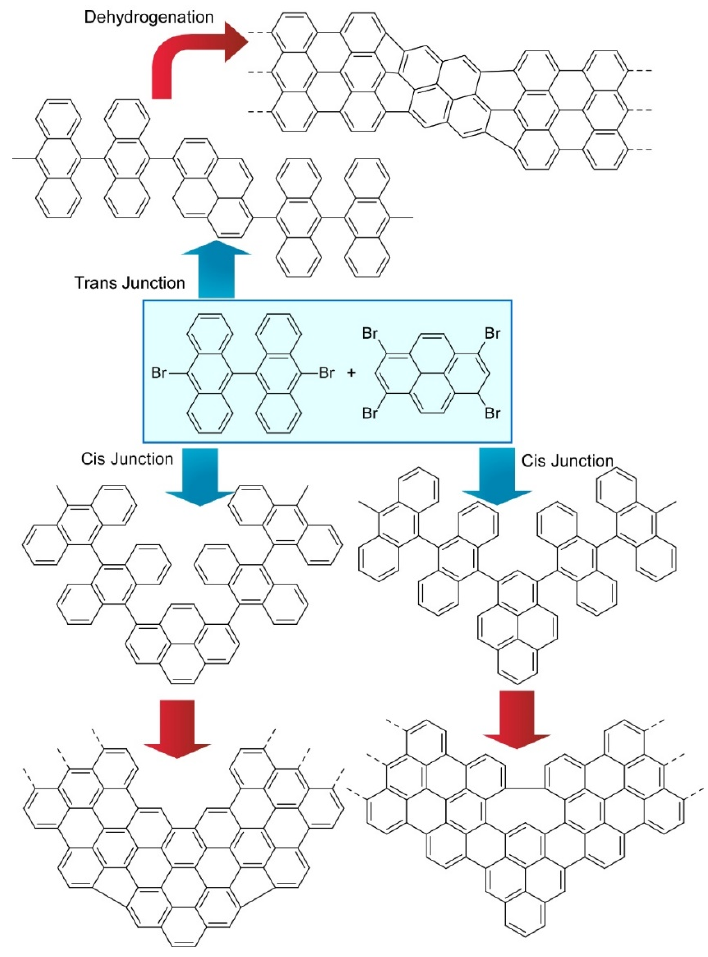
Figure 8. Three different regioisomeric junctions synthesized from 10,10’-dibromo-9,9’-bianthryl and 1,3,6,8-tetrabromopyrene on Au (111) surface.